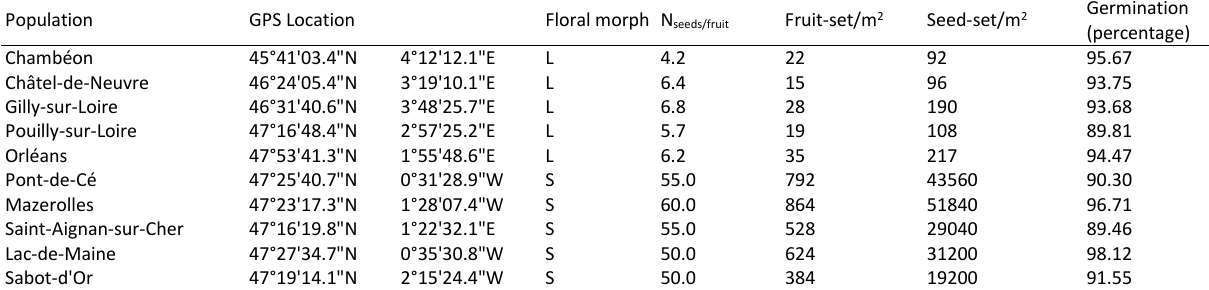
Table S1: Fruit-set, seed-set and germination rate in five S-morph and five L-morph monomorphic in natura populations in western Europe. Mean number of seeds per fruit (N seeds/fruit ), fruit-set per square meter, seed-set per square meter produced in the studied in natura monomorphic populations of Lgh . Seed-set productions per m 2 in monomorphic S-morph populations were estimated by counting the number of seeds produced by fruits in 5 quadrats of 1m 2 and multiplied by the mean number of counted fruits per quadrat. Seed-set productions per 1m² in L-morph populations are reported as the exhaustive number of seeds within all the fruits found in the quadrats of one square meter. Population GPS Location Floral morph N seeds/fruit Fruit-set/m 2 Seed-set/m 2